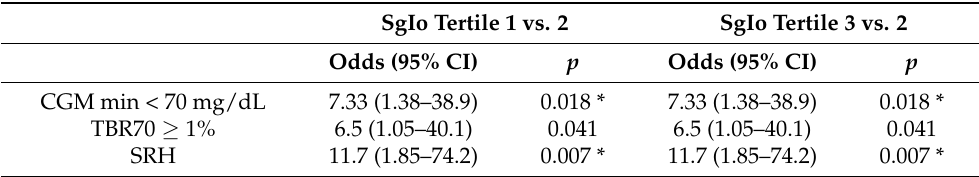
Table 4. The odds ratios of SgIo tertiles 1 and 3 for belonging to the hypoglycemic categories vs. SgIo tertile 2.